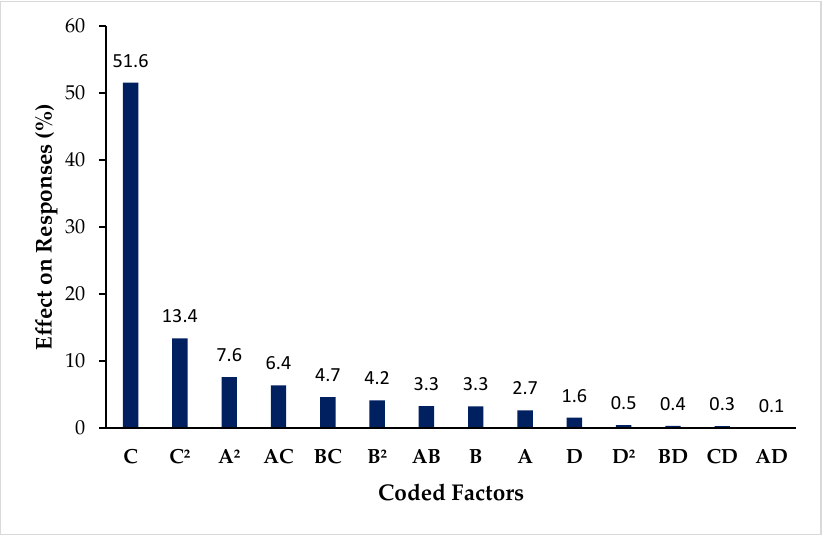
Figure 5. Pareto showing the effect of each coded term on all the responses (microcapsule size, sphericity, and yield).